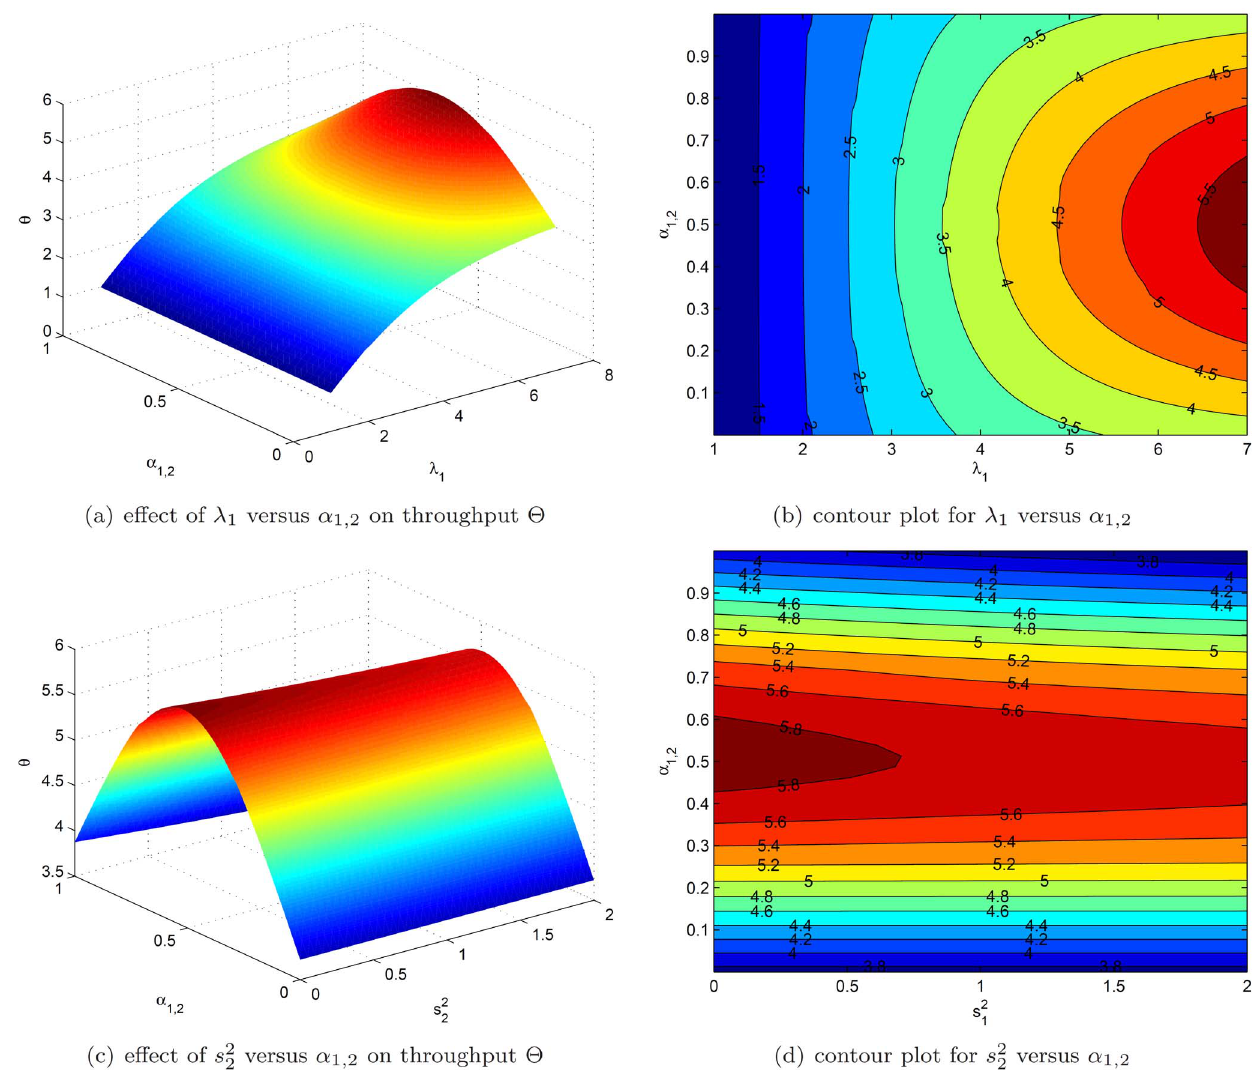
Figure 4. The shape of the objective function.